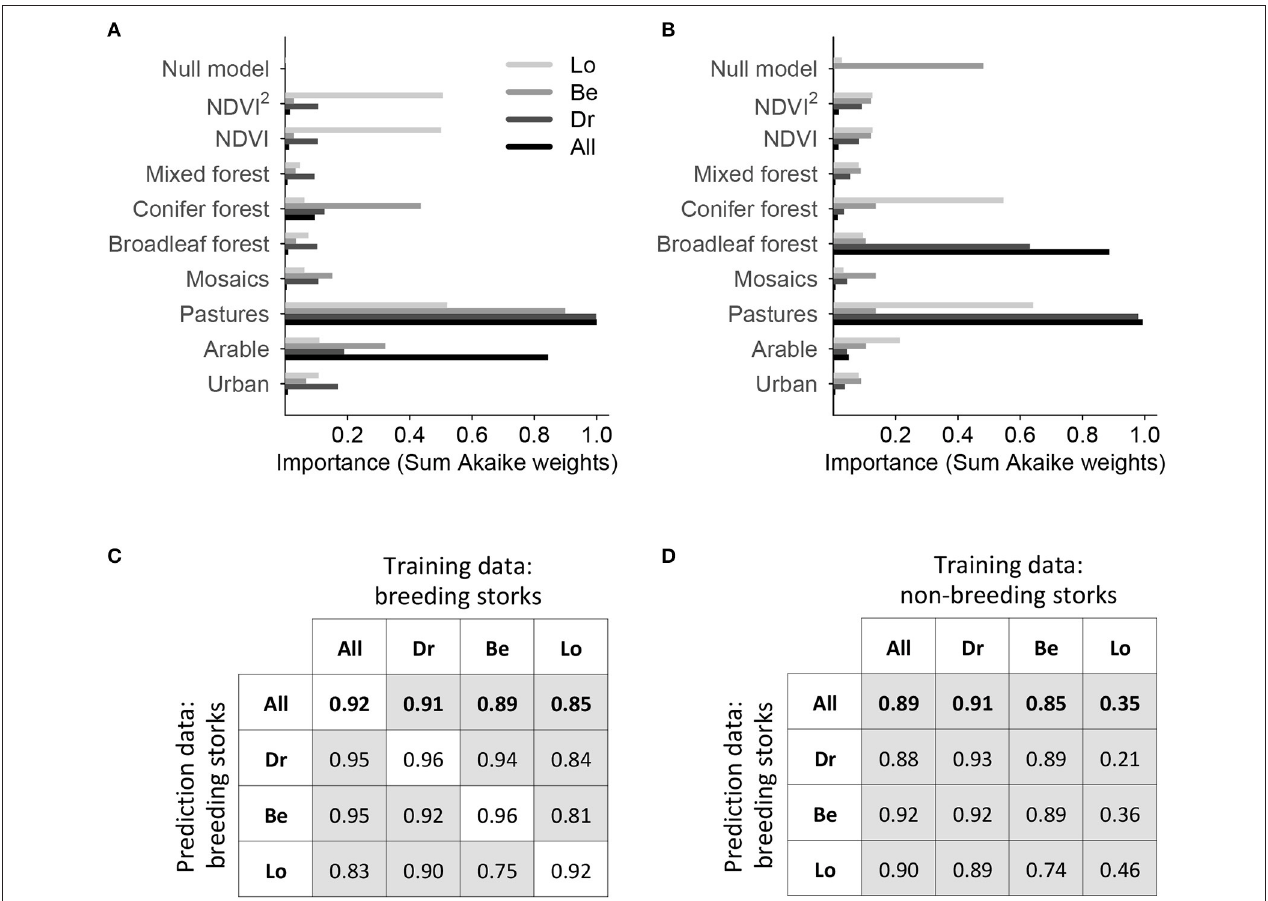
FIGURE 2 | Variable importance (A,B) and cross-prediction results (C,D) of home range selection models for breeding (A,C) and non-breeding white storks (B,D). To reduce bias from small sample sizes, we used ensembles of small bivariate generalized linear models fitted with binomial error structure (1 for occupied home range, 0 for random home range). Models were fitted for the entire study area (All = entire region) and for single regions (Dr, Drömling; Be, Beuster; Lo, Loburg). (A,B) Variable importance for each region and breeding status is given by the sum of Akaike weights over all bivariate models including the respective variable. (C,D) We assessed the ability of the ensembles to predict breeding home ranges in the entire area or single regions by calculating the area under ROC curve (AUC), which ranges between 0 and 1, with 1 indicating perfect discrimination and 0.5 predictions no better than chance. AUC scores for predicting all breeding storks are highlighted in bold. White boxes indicate internal predictions, meaning that training and prediction data were